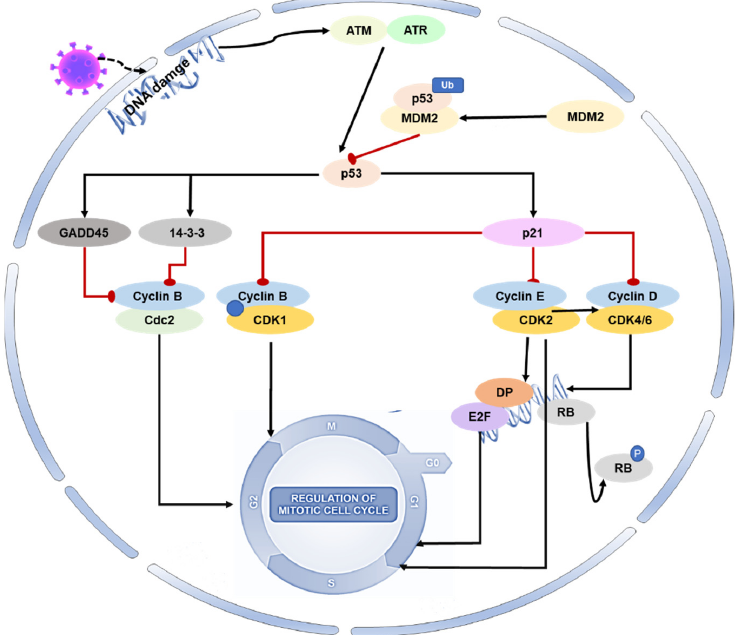
Figure 2. Role of p53 on the cell cycle during coronavirus infection. During viral infection, p53